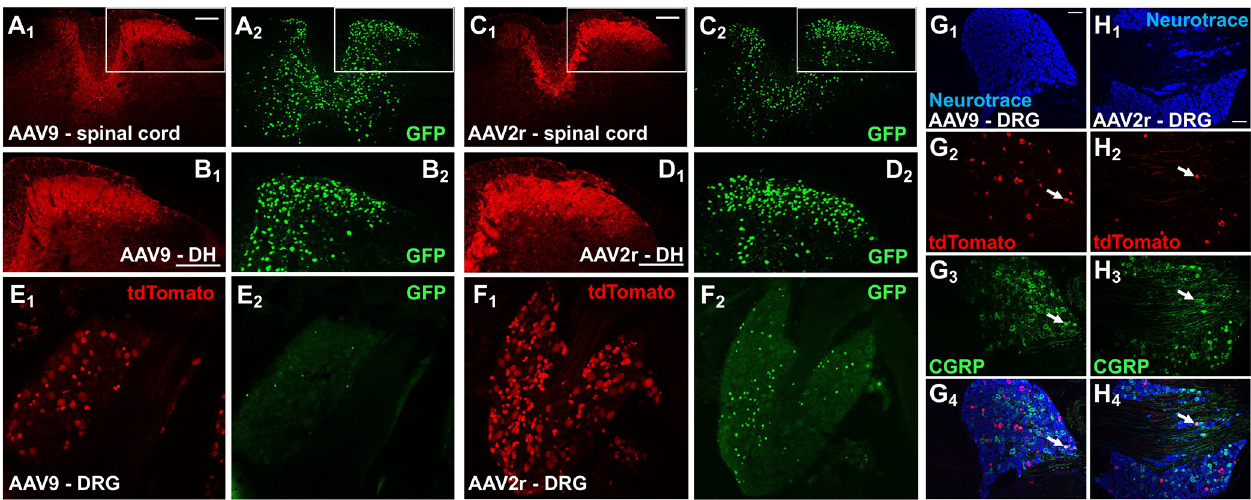
Fig 2. Intraspinal delivery of AAV9 and AAV2retro viral vectors leads to effective transduction of both spinal and primary afferent neurons. A-D, tdTomato (red, subscript 1) and GFP (green, subscript 2) immunofluorescence in Ai14 mice injected unilaterally in the L3/L4 region of spinal cord with AAV9 (A and B), or AAV2retro (C and D); scale bars = 150 μ m. The discrepancy in the tdTomato and GFP labeling is largely due to the differential subcellular localization of the two reporter proteins, and more specifically to the overwhelming tdTomato labeling in the neuropil of densely transduced dorsal horn regions and in the central processes of transduced DRG neurons. The high fluorescence intensity of these regions required imaging parameters that were not optimal for regions with lower density of transduced neurons. In contrast, the discrete nuclear localization of Cre-GFP allowed clear visualization of individual nuclei in the spinal cord. E and F , tdTomato (red, subscript 1) and GFP (green, subscript 2) immunofluorescence in neurons of the ipsilateral L4 DRG following transduction with AAV9 (E) or AAV2retro (F); not all tdTomato-labeled cells were immunoreactive for nuclear GFP, scale bars = 150 μ m. G and H , NeuroTrace staining (blue, subscript 1), tdTomato (red, subscript 2) and CGRP (green, subscript 3) immunofluorescence in the ipsilateral L4 DRG following transduction with AAV9 (G) or AAV2retro (H); arrows point to examples of tdTomato and CGRP colocalization, scale bars = 100 μ